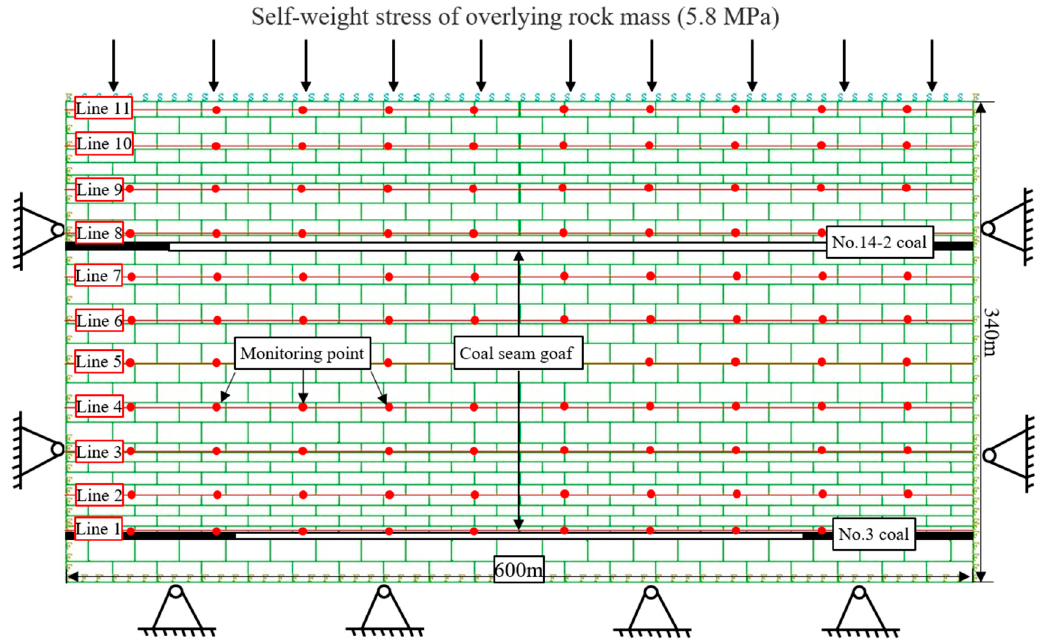
Figure 4. Schematic diagram of numerical simulation model.